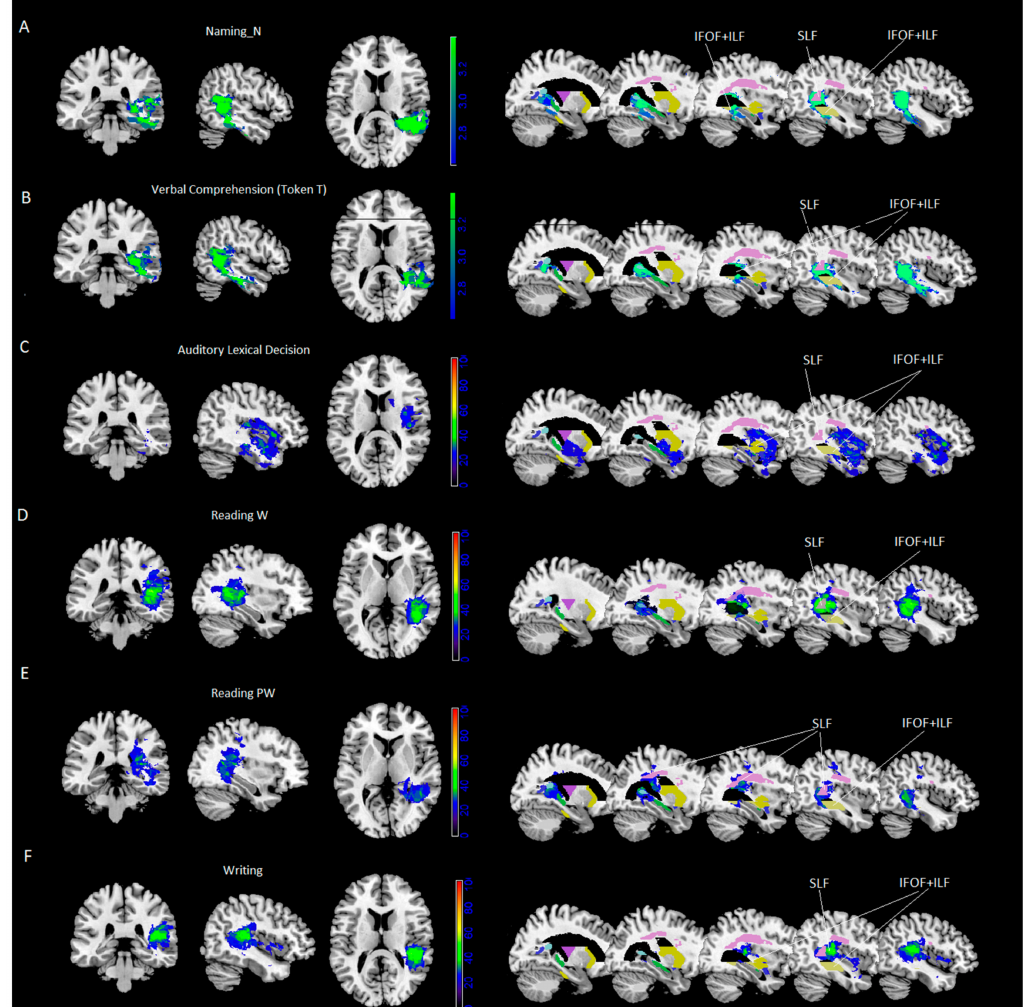
Figure 1. VLSM templates showing lesions significantly affecting performance on ( A ) noun naming and ( B ) token test. ( p < 0.01, thresholds based on permutation method). Subtraction of lesion masks ( C – F ) of patients scoring pathologically from patients with normal performance (minimum 20% overlap) on the different tasks. MR images are displayed following radiological convention (left is right and vice versa). On the right side of the panel, results overlap with the JUH template of white matter pathways on sagittal slices. SLF = superior longitudinal fasciculus, IFOF = inferior fronto-occipital fasciculus; ILF = inferior longitudinal fasciculus belonging to sagittal stratum. N = nouns; W = words; PW = pseudowords; Token T = Token test.